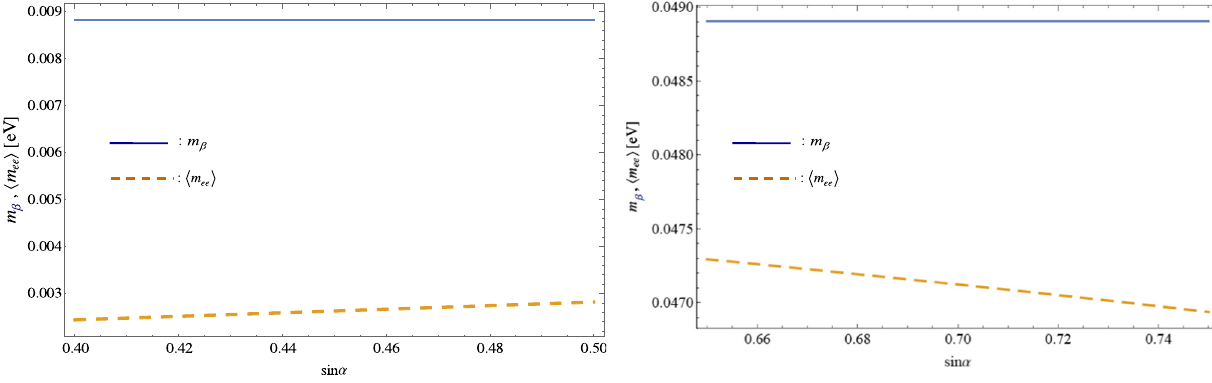
Fig. 4 (cid:4) m ee (cid:5) and m β versus sin α with sin α ∈ ( 0 . 40 , 0 . 50 ) for NH (left figure) and sin α ∈ ( 0 . 65 , 0 . 75 ) for IH (right figure) ! 2 . 08 × 10 − 2 eV for NH k = 2